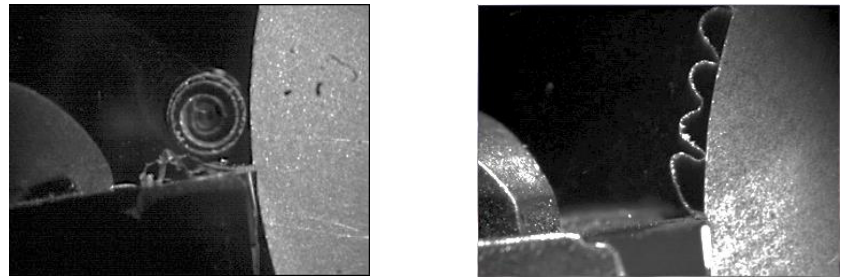
Figure 18. High-speed camera observation of the chip discharge state ( left : v 25 m/min, right : v 100 m/min).